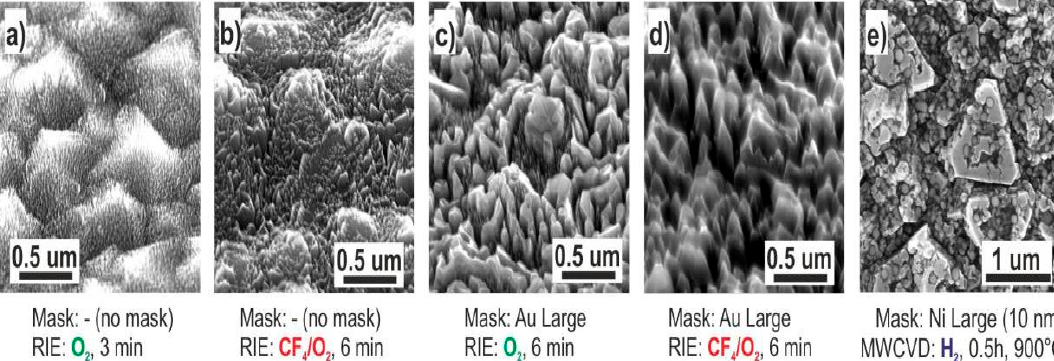
Figure 2. Representative 45° angled-view SEM images of selected samples: ( a ) needle-like structures (whiskers), ( b ) BDD nanocones, ( c ) nanorods with needles or ( d ) without needles, and ( e )